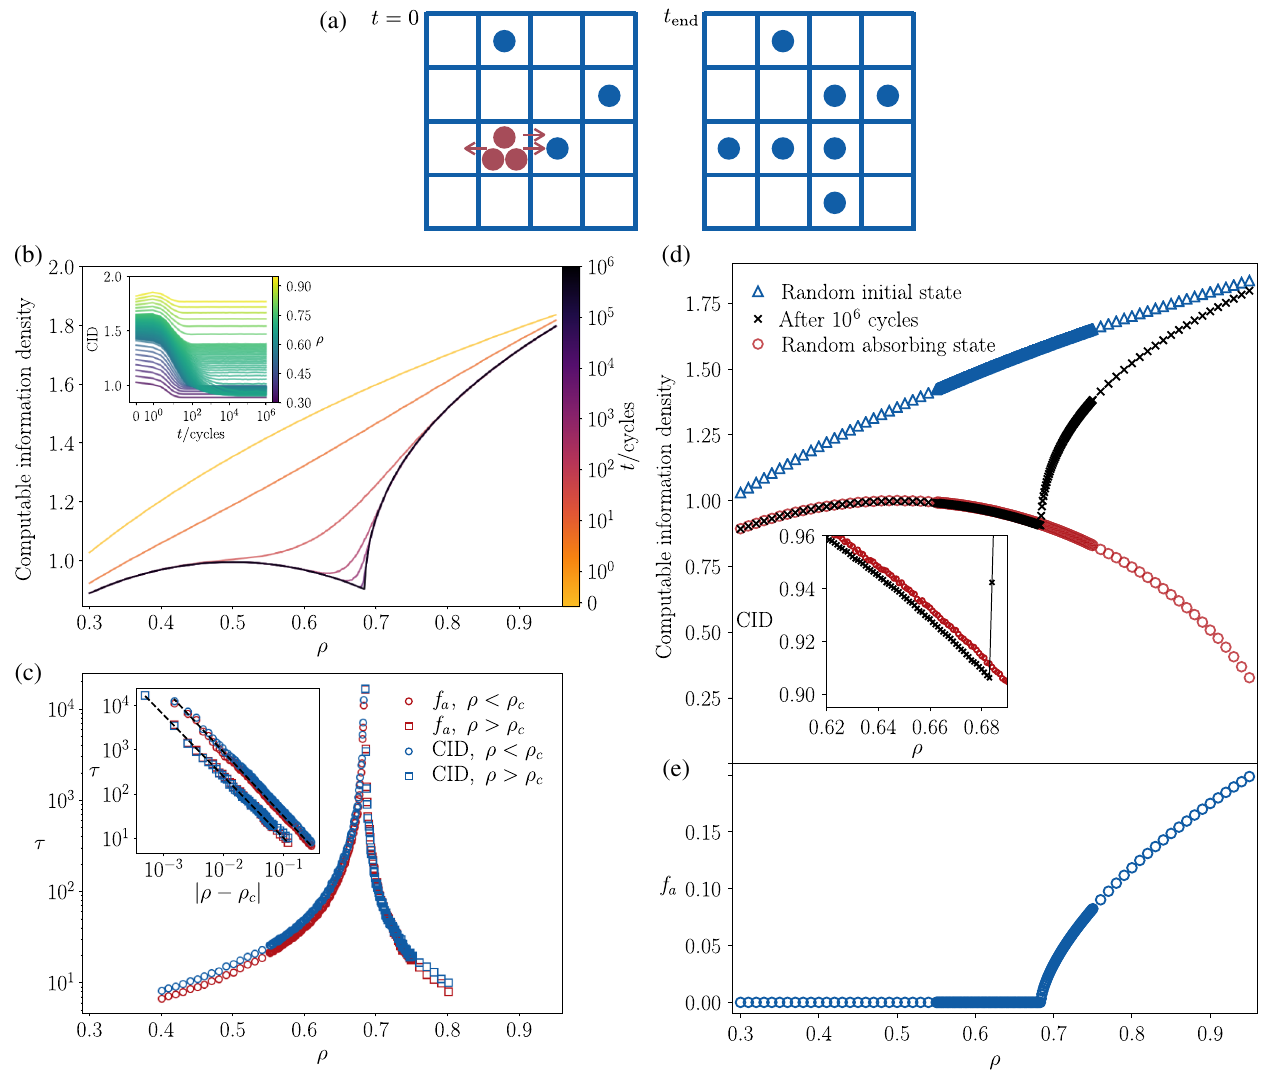
1 . (a) At time t ¼ 0 the system is in a randomly sampled state and sites FIG. 3. 2D Manna model with size 2 10 × 2 10 and z max ¼ occupied by more than z particles are active (active sites in red). At each time step, a randomly sampled active site is emptied by max redistributing all particles to its nearest neighbors, a possible move is illustrated by the red arrows. When the particle density is below the 0 . (b) CID as a function of particle critical density ρ , the system relaxes to an absorbing state, such that the fraction of active sites f c a ¼ density ρ for different times; a cycle corresponds to L randomly attempted moves. The system orders as a function of time, developing a ≈ 0 . 683 . The inset shows the CID time-evolution profile for several densities. (c) Characteristic cusp minimum at the critical density ρ c time τ as a function of density ρ , as measured by the decay of f and CID, exhibiting a divergence near ρ , in line with the cusp minimum a c in panel (b). The inset shows τ as a function of j ρ − ρ , exhibiting identical power-law divergence and critical exponent ν ¼ 1 . 3 (cid:2) 0 . 2 c j k from both measures. Lines of best fit (dashed black lines) were obtained by bootstrapped minimum mean-square error fits using a robust covariance estimator [38,39]. (d) Comparison of the random initial states (blue triangles), states found by the dynamics after 10 6 cycles (black crosses) and random (uniformly sampled) absorbing states (red circles); the inset shows that near the critical point the absorbing states arrived at by the dynamics have lower CID, and are more ordered than the uniformly sampled ones. (e) Fraction of active sites as a function of ρ